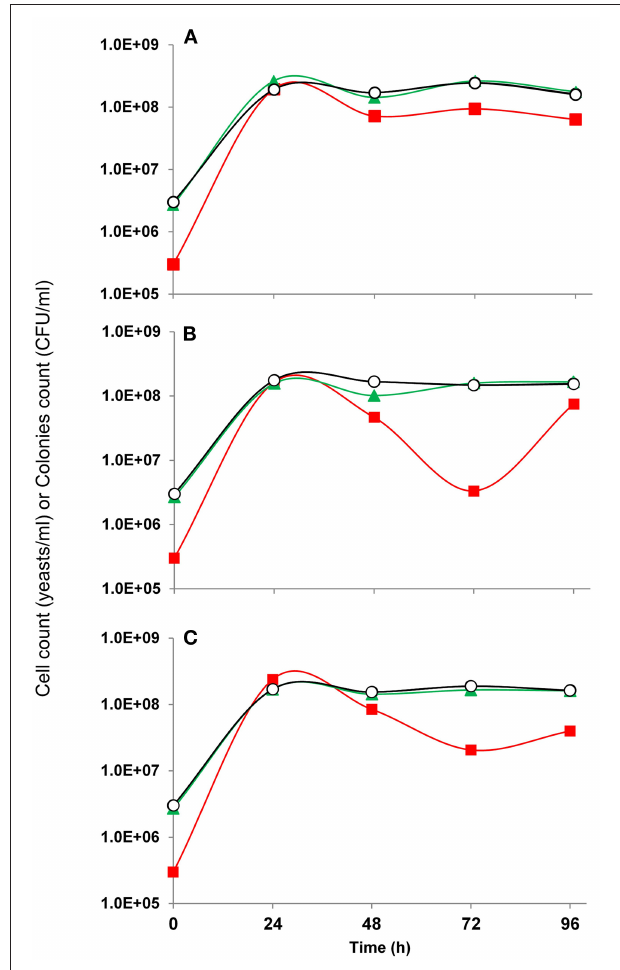
FIGURE 3 | Population growth kinetics of mixed cultures of mezcal S. cerevisiae and non- Saccharomyces ( Torulaspora delbrueckii ) strains fermenting Agave medium. (A) Sc3Y3-Td1AN9, (B) Sc3Y4-Td1AN9, (C) Sc3Y8-Td1AN9. The data shown were obtained from triplicates of two independent experiments. Markers are average values of: total cell count (yeasts/ml), Td (CFU/ml), Sc (CFU/ml), – (cid:13) – viable cell count (viable yeasts/ml). Standard deviation was below 10% for all data. Notice that total and viable cell count markers